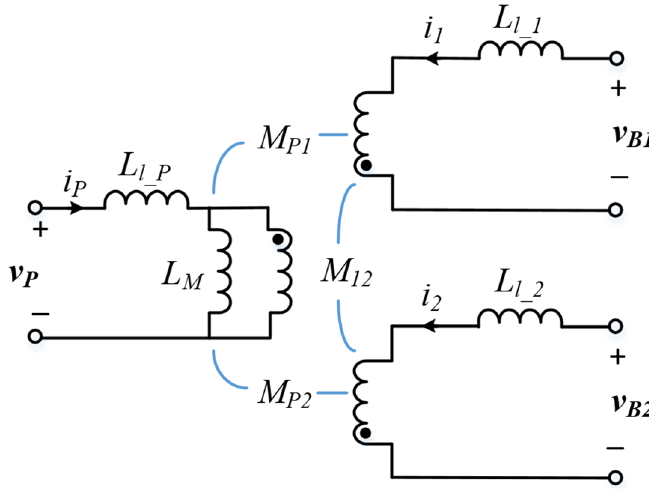
Figure 9. Multi transformer with cells.